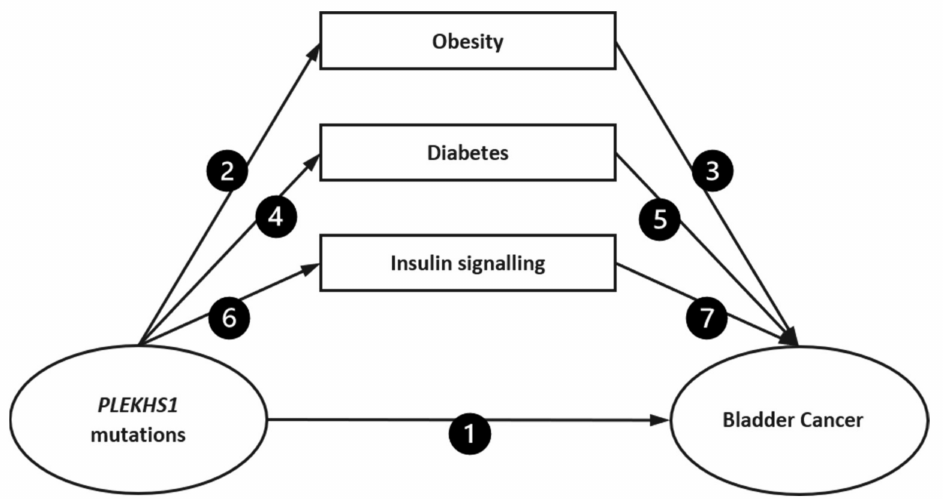
Figure 1. Search strategy. The figure shows the seven literature searches performed: (1) PLEKHS1 mu- tations and bladder cancer incidence and outcomes, (2) PLEKHS1 mutations and obesity, (3) obesity and bladder cancer incidence and outcomes, (4) PLEKHS1 mutations and diabetes, (5) diabetes and bladder cancer incidence and outcomes, (6) PLEKHS1 mutations and insulin signalling, (7) insulin signalling and bladder cancer incidence and